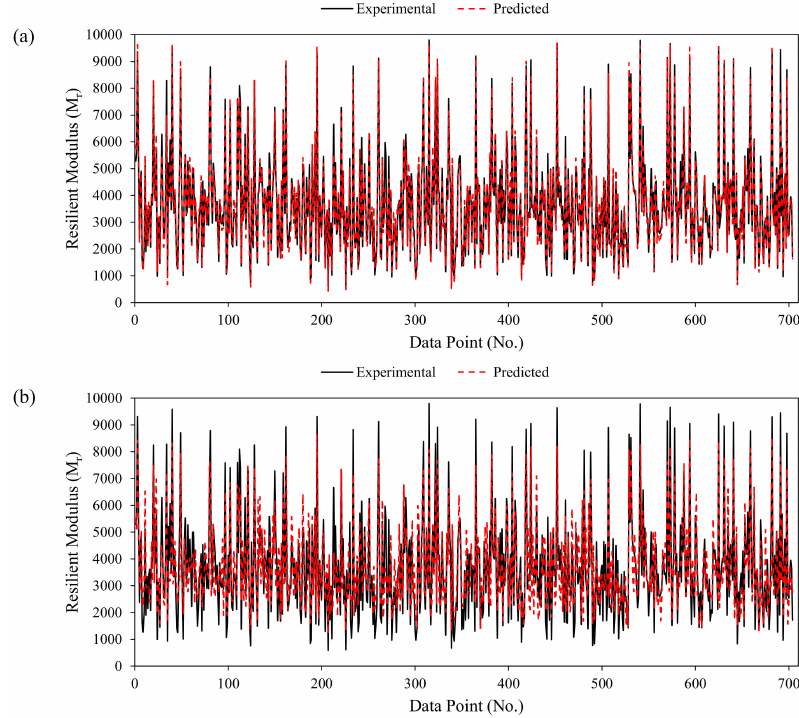
Figure 8. Comparison of the proposed models: ( a ) ANN; ( b )